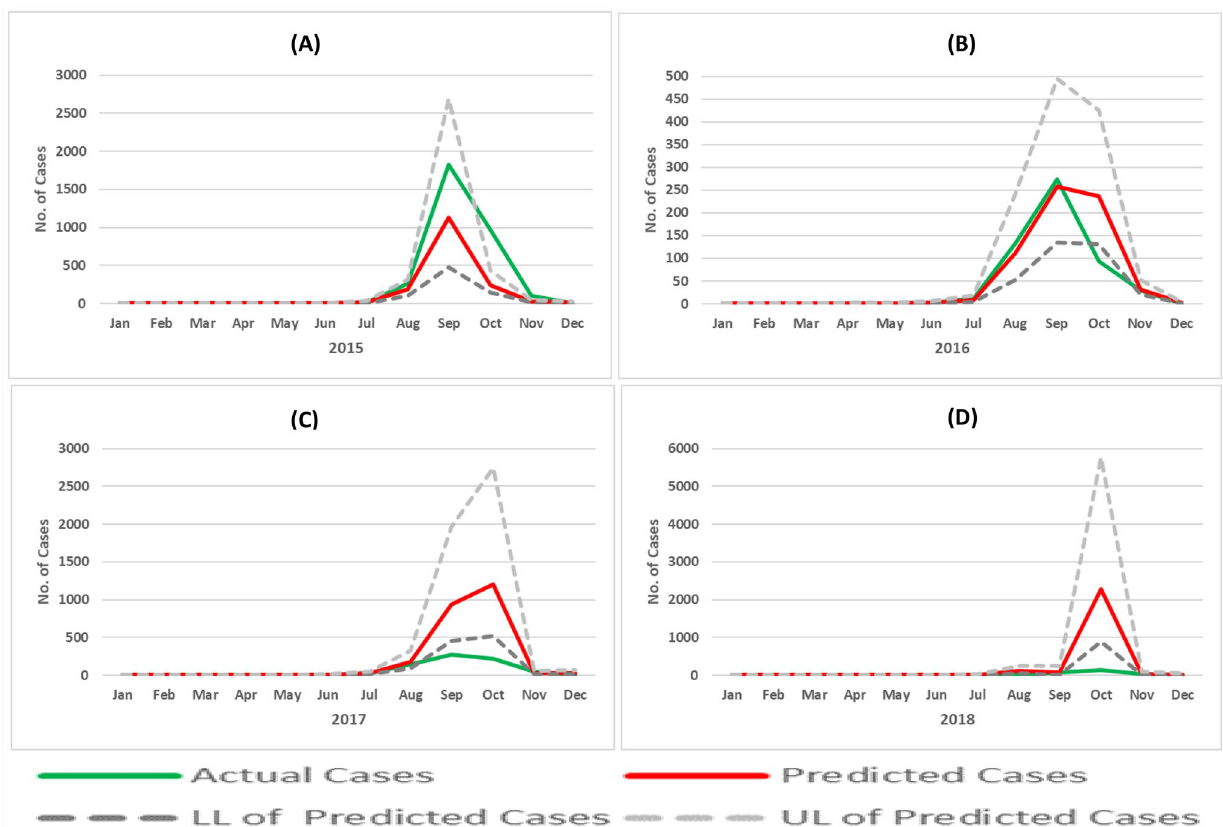
Figure 6. Actual and predicted values of dengue cases with best fit Generalized Linear Model (GLM) using Negative Binomial Regression